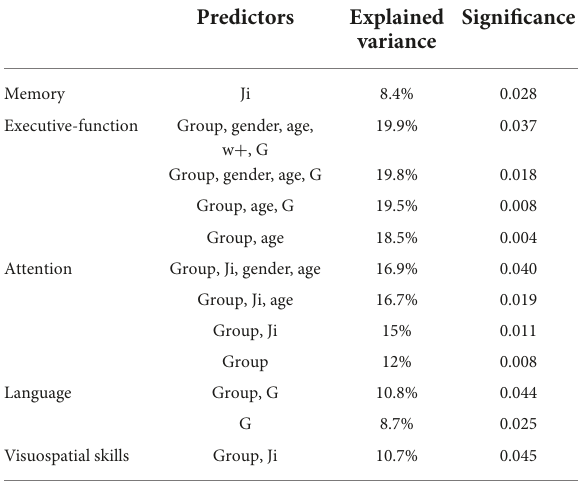
TABLE 3 Backward regressions results.